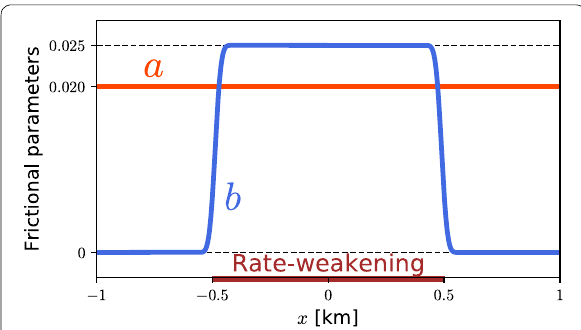
Fig. 2 Spatial variation in frictional parameters a and b in the rate- and state-dependent friction (RSF) law. a is uniform and b is given by a smoothed boxcar function (e.g., Noda and Lapusta 2010). In the central part of the rate-weakening patch, a / b =